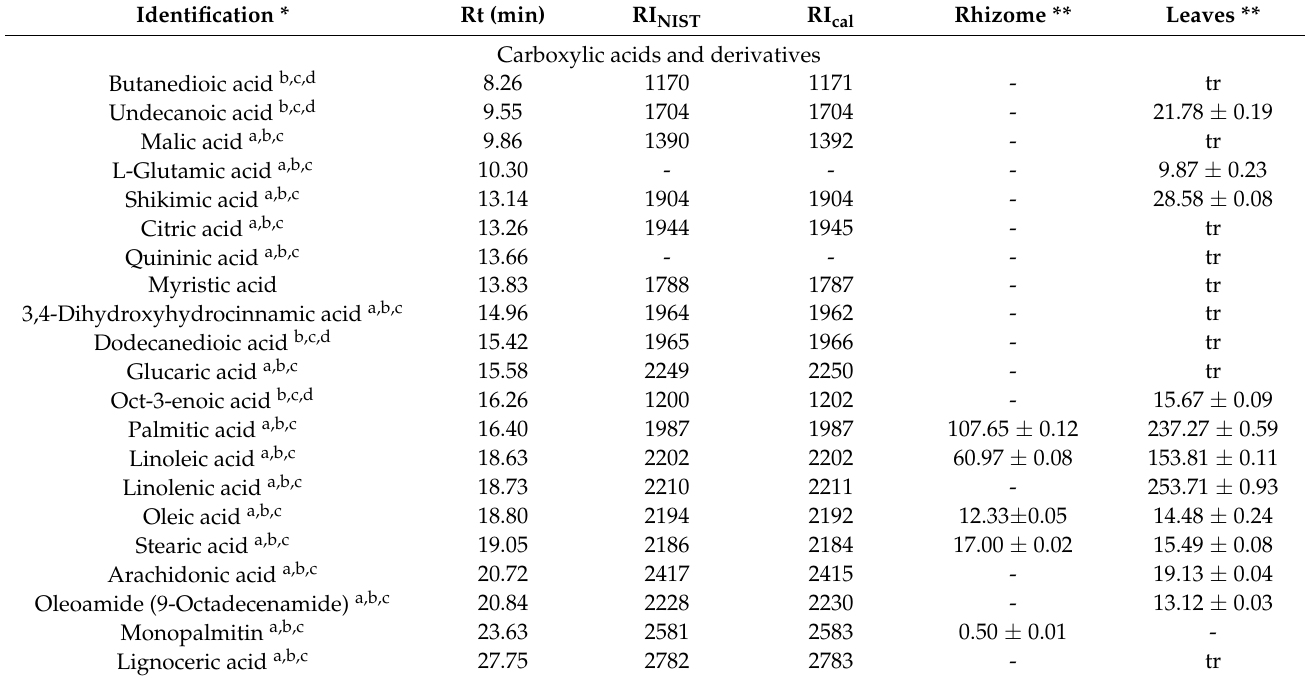
Figure 1. Total ion chromatogram (TIC) of A. quercifolia rhizomes ( a ) and leaves ( b ) n -hexane extracts with time in minutes. Table 3. Identified compounds on the n -hexane extract of A. quercifolia rhizome and